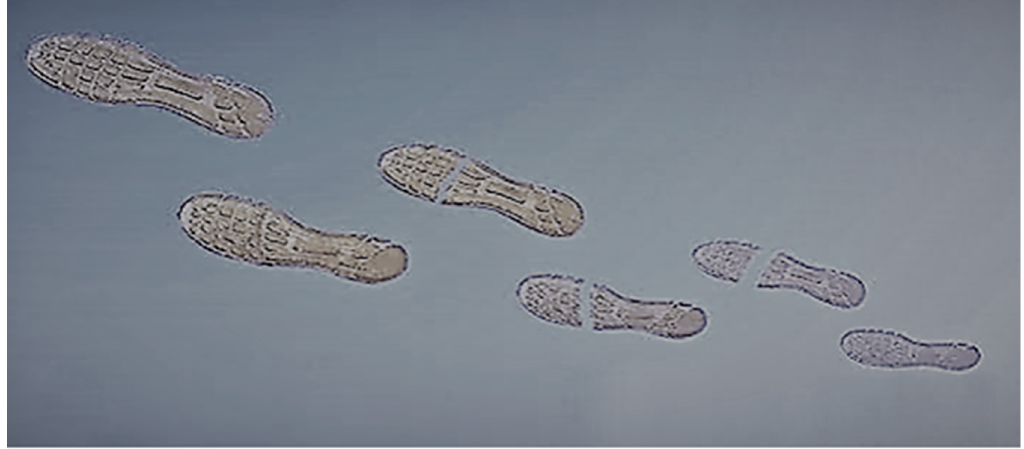
Figure 14. Severed 3D-printed shoe pad self-healing itself. (Adapted from [67]).